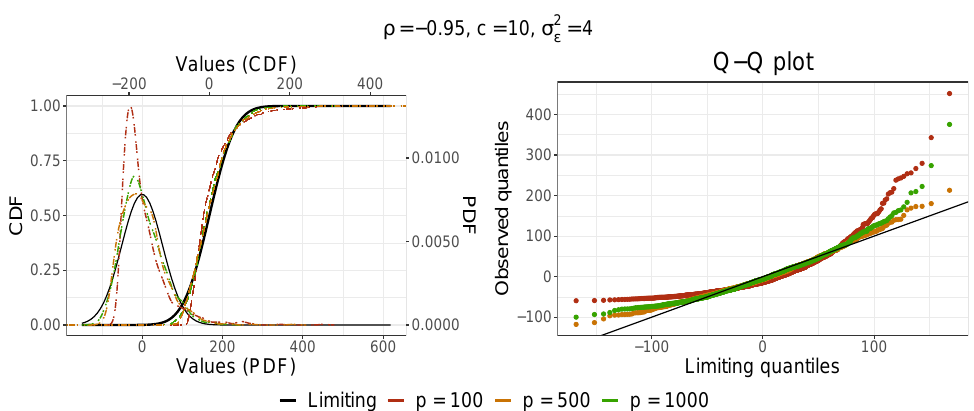
Figure 8. Comparison of the PDF and CDF ( left ) and the corresponding Q-Q plots ( right ) after 1000 replications from the Monte Carlo simulation of the statistic (80) with the limiting distribution N ( 0, s 2 ) by the Corollary 2 (in black) for (cid:36) = − 0.95, c = 10, σ 2